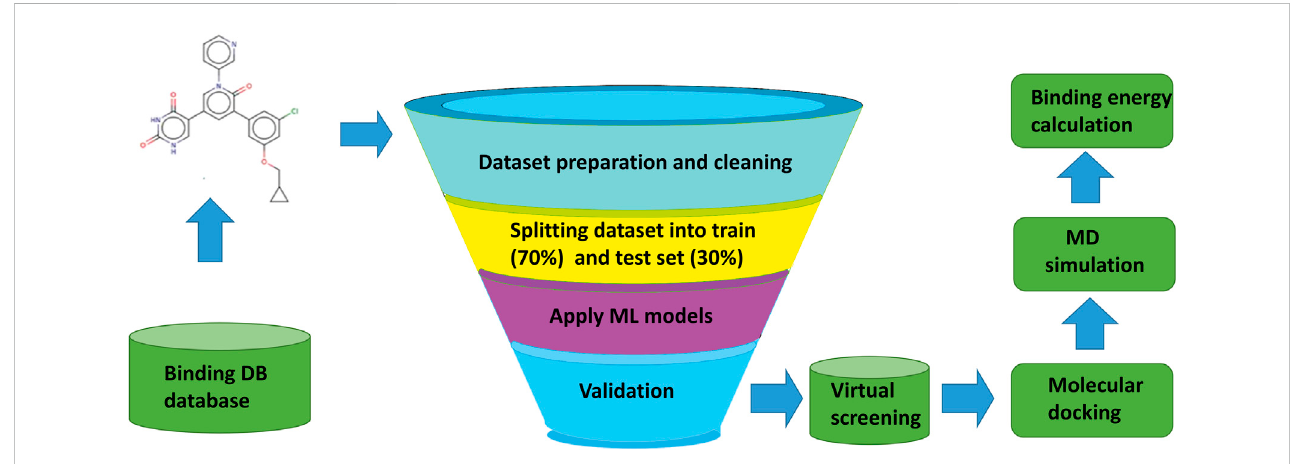
FIGURE 1 Overallwork fl owofmachinelearningbasedvirtual screening, molecular docking,andMDsimulationstudy for3CL PRO (3Clikeprotease)avalidateddrug target in